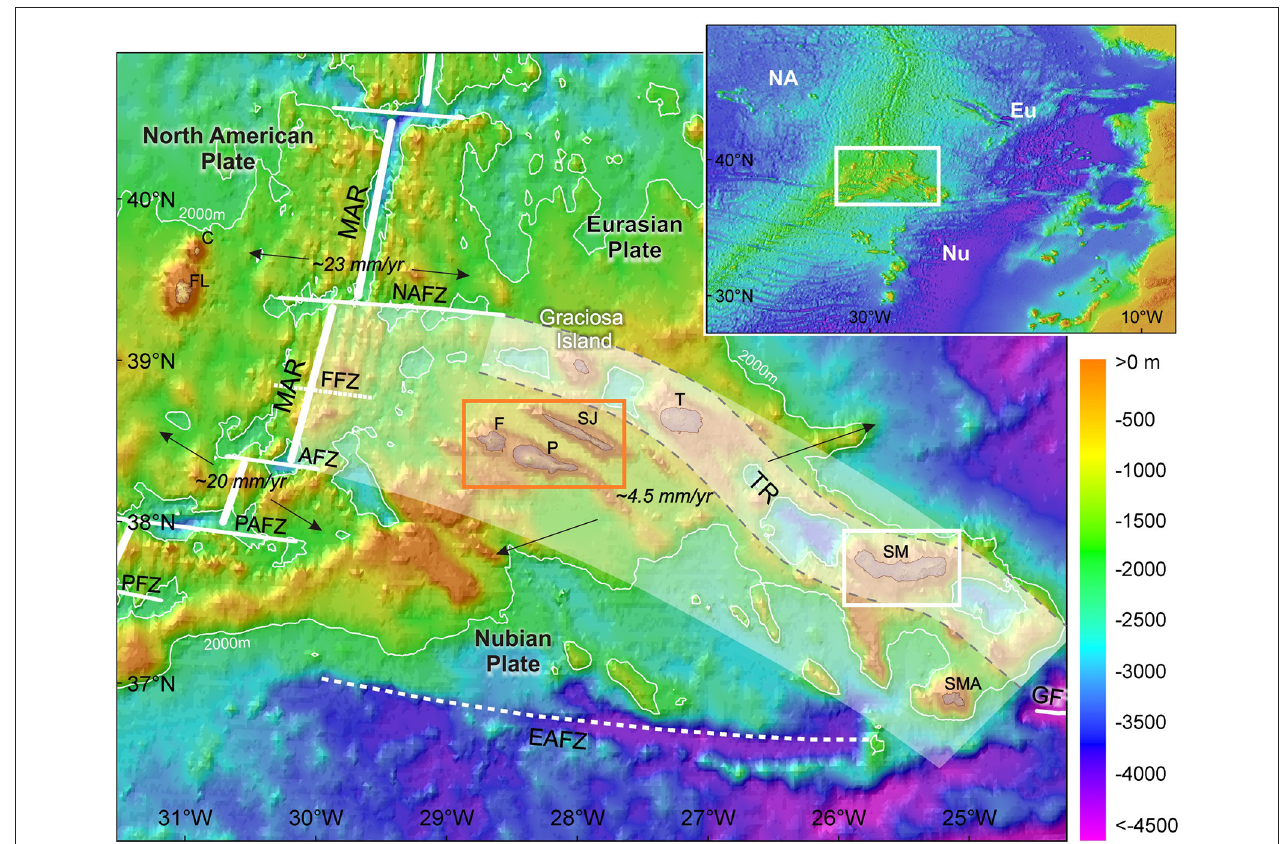
FIGURE 1 | Main morphotectonic features of the Azores region. White lines define approximately the morphological expression of each structure; white shaded area represents the sheared western segment of the Eu-Nu plate boundary, whereas the white shaded area limited by a dotted gray line represents its main structure, the Terceira Rift (TR). Tectonic structures: MAR, Mid-Atlantic Ridge; EAFZ, East Azores Facture Zone; NAEZ, North Azores Fracture Zone; GF, Gloria Fault; FFZ, Faial Fracture Zone; AFZ, Açor Fracture Zone; PAFZ, Princesa Alice Fracture Zone; PFZ, Pico Facture Zone. Islands: SMA, Santa Maria; SM, São Miguel; T, Terceira; SJ, São Jorge; P, Pico; F, Faial; FL, Flores; C, Corvo. Azores bathymetry adapted Lourenço et al. (1997); World topography and bathymetry from GEBCO_08 database (2010). Datum: WGS 1984 (in Hipólito et al., 2013); The red square shows the area that comprises the three studied islands.